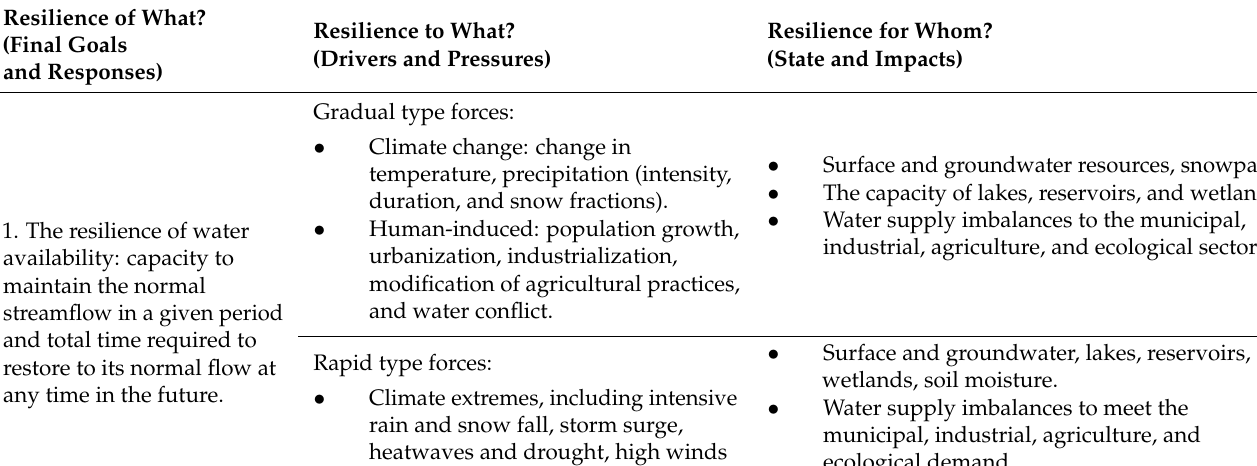
Table 3. Outlines of resilience analysis for water resources and infrastructure